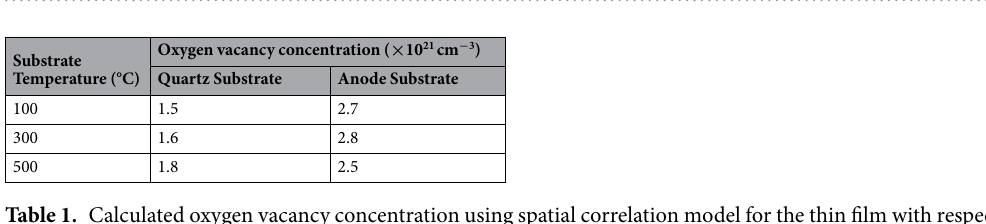
Figure 10. Raman Spectra of SDC thin film deposited at 100, 300 and 500 °C substrate temperature.